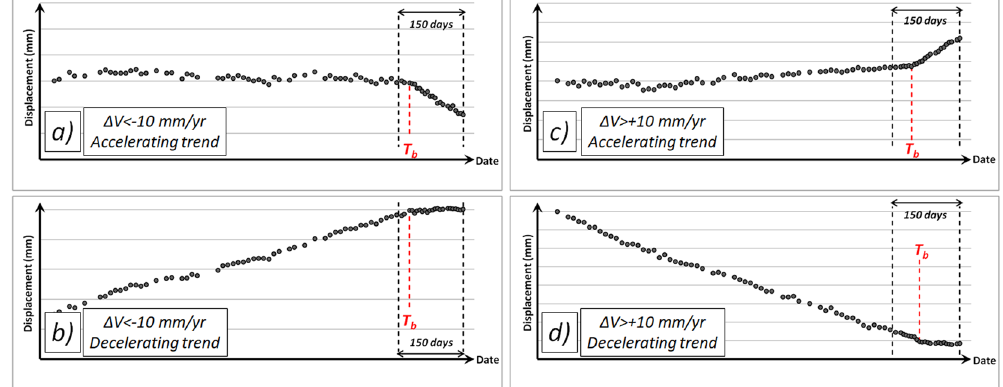
Figure 6. Time series of anomalous points with different trend changes. The sign of Δ V coupled with slope and slope aspect derived from a Digital Elevation Model (DEM) support the characterization of the phenomenon affecting the measurement point and the identification of possible